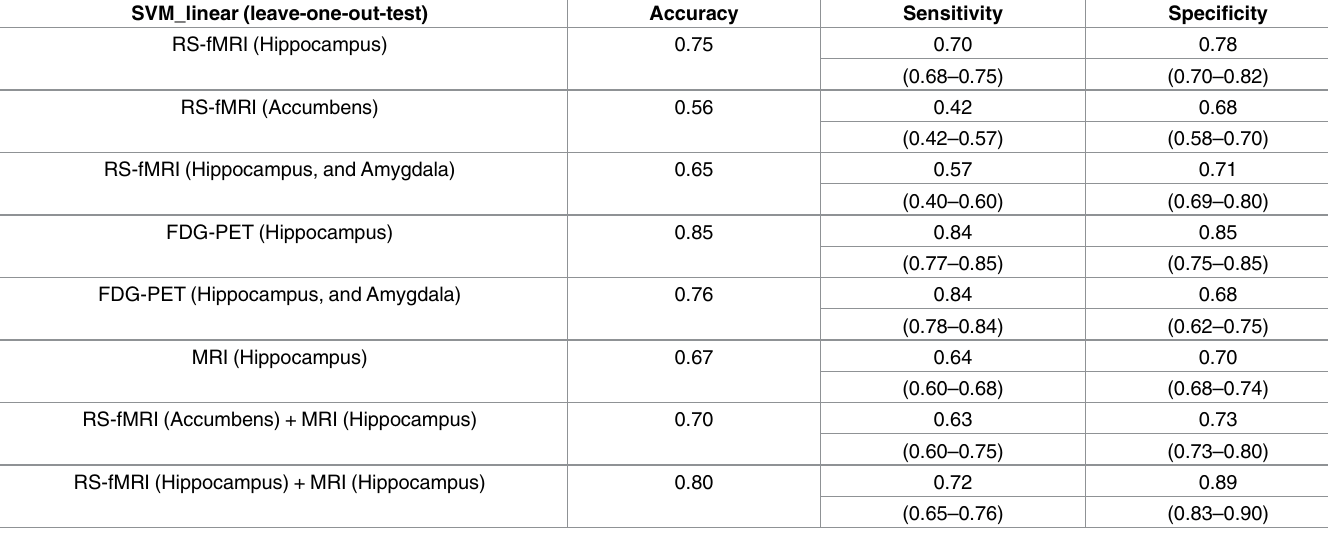
Table 2. Classification results for RS-fMRI brain activity, glucose metabolism measuredby FDG-PET SUVR, and normalized volume measured using MRI. The 95% confidenceinterval (CI) is providedin parentheses. SVM_linear (leave-one-out-test)